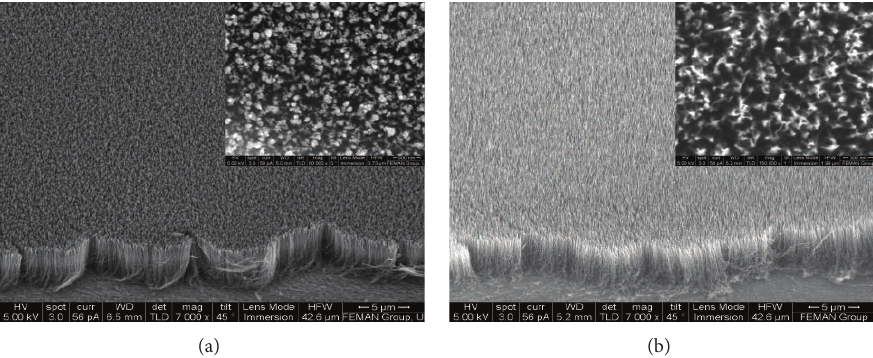
Figure 1: SEM images of untreated CNTs (a) and wpCNTs (b). Inset graphs show top view of the CNTs mat.